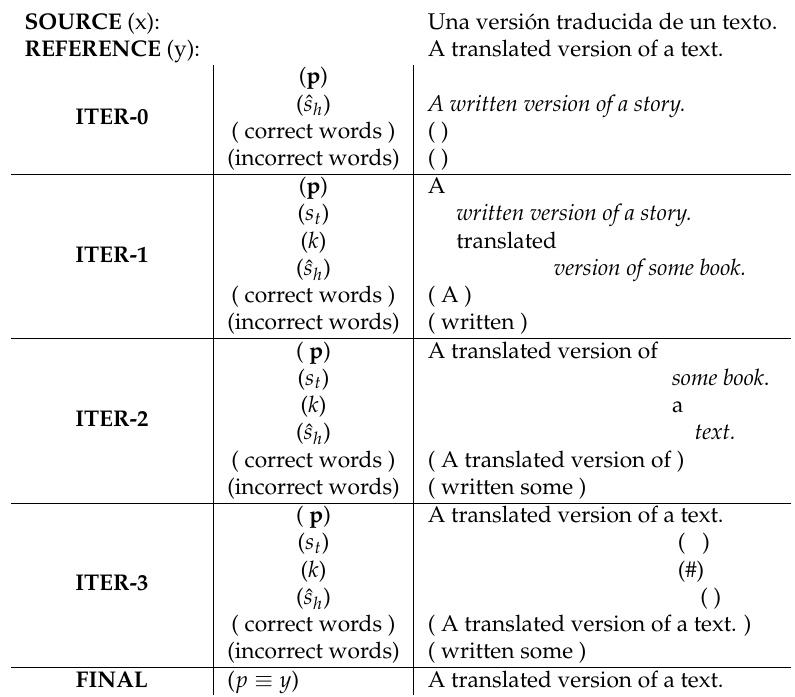
Figure 2. Example of a conventional prefix-based IPNMT session without CMs to translate a sentence from Spanish to English. Non-validated hypotheses are displayed in italics , and accepted prefixes are printed in normal font. ‘#’ represents the translation validation action. This process obtains a set of correct and incorrect words for each sentence. We used the dataset acquired from this procedure to study the robustness of the CMs.